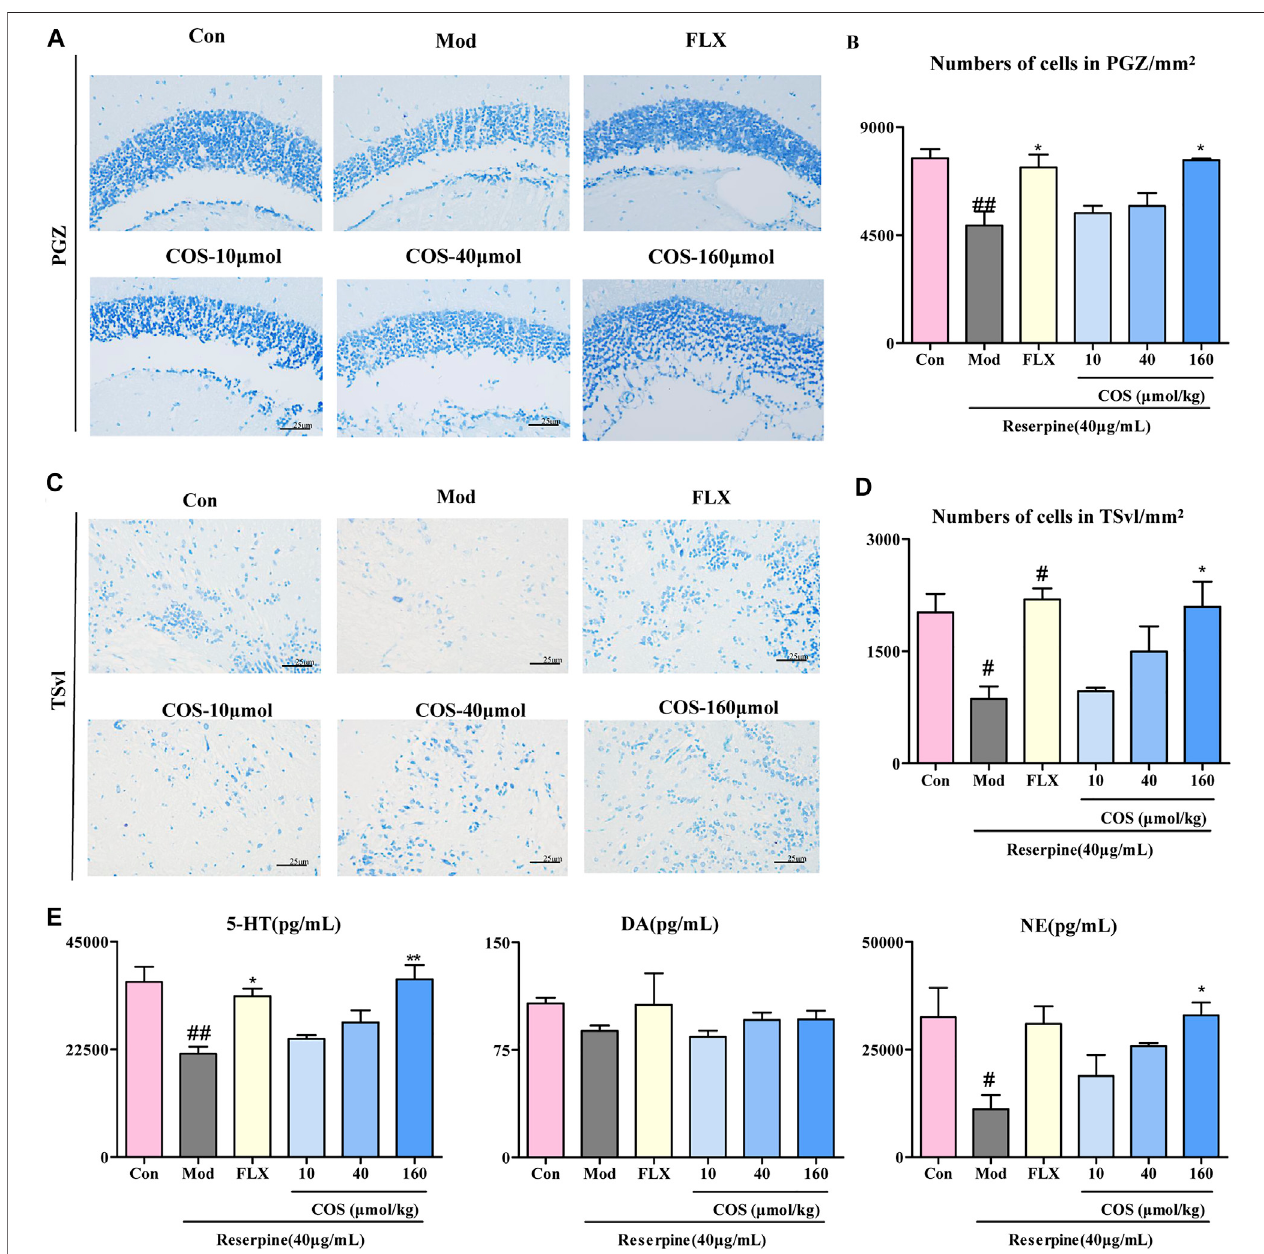
FIGURE 5 | Protective effect of costunolide (COS) on reserpine-induced neuronal injury. (A) . Nissl stain of the zebra fi sh brain (400 × ) in periglomerular gray zone (PGZ) (C) . Nissl stain of the zebra fi sh brain (400 × ) in ventrolateral nucleus of the semicircular torus (TSvl). (B and D) are the quantitative statistics of neurons of the PGZ and TSyl, respectively. (E) . The content of 5-HT, DA, NE in zebra fi sh brain was measured via ELISA. Data are expressed as the mean ± SEM (n (cid:1) 3/group). Signi fi cance was de fi ned as # p < 0.05, ## p < 0.01, * p < 0.05, ** p < 0.01.